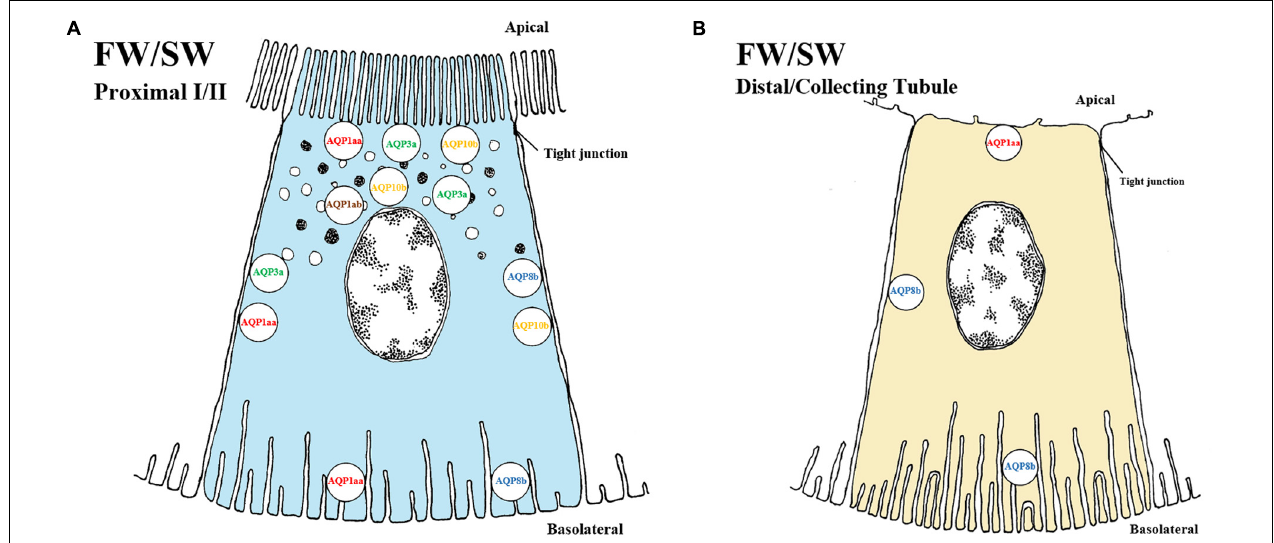
FIGURE 4 | Schematic overview showing localization of AQP (aquaporins) in kidney of teleosts. The localization of several AQP transporters in both proximal (A) and distal/collecting (B) segments of the kidney. No difference is observed between FW and SW environments of any of the above AQP in the fish kidney. The AQPs are located in apical, sub-apical, lateral and basolateral positions in proximal tubules while no sub-apical location of AQPs has been found in the distal/collecting tubule. The approximate location of each AQP is as follows: AQP1aa (red, apical/lateral/basolateral), AQP1ab (brown, sub-apical), AQP3a (green, apical/sub-apical/lateral), AQP8b (blue, lateral/basolateral) and AQP10b (yellow, apical/sub-apical/lateral). In the distal/collecting tubule only AQP1aa and AQP8b have been discovered/located. AQP distribution in proximal tubule I and II as well as distal and collecting tubule have not been differentiated and need to be experimentally determined. Models are based on the paper of Engelund and Madsen